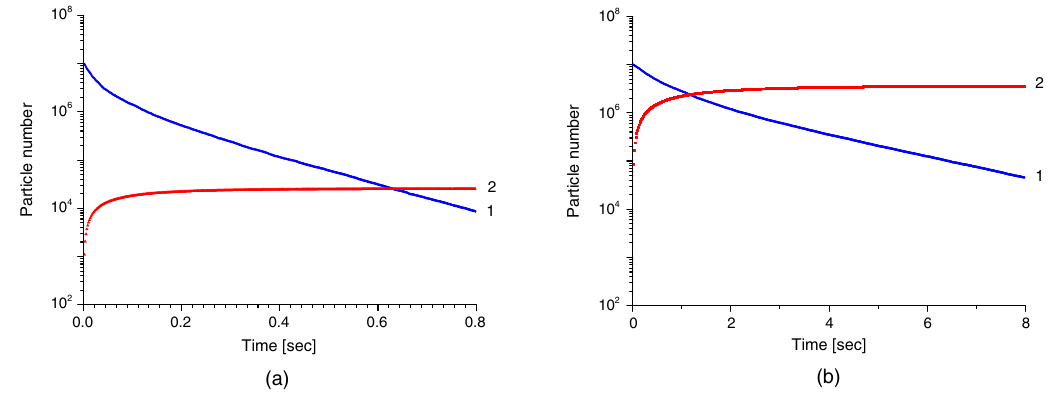
FIG. 12. Losses of a high-intensity ( N o ¼ 10 7 ions) beam (black) and total number of ionization events (red) during multiple ¼ 5 (cid:6) 10 11 cm (cid:3) 3 : (a) energy of projectile ions is 3 keV, number of crossing of antiprotons and a helium gas jet. Target density is n tgt ionization events is 2 : 6 (cid:6) 10 4 (curve 1), and lifetime is about 100 ms (curve 2); (b) energy of projectile ions is 30 keV, number of ionization events is 3 : 2 (cid:6) 10 6 (curve 1), lifetime is 1.3 s (curve